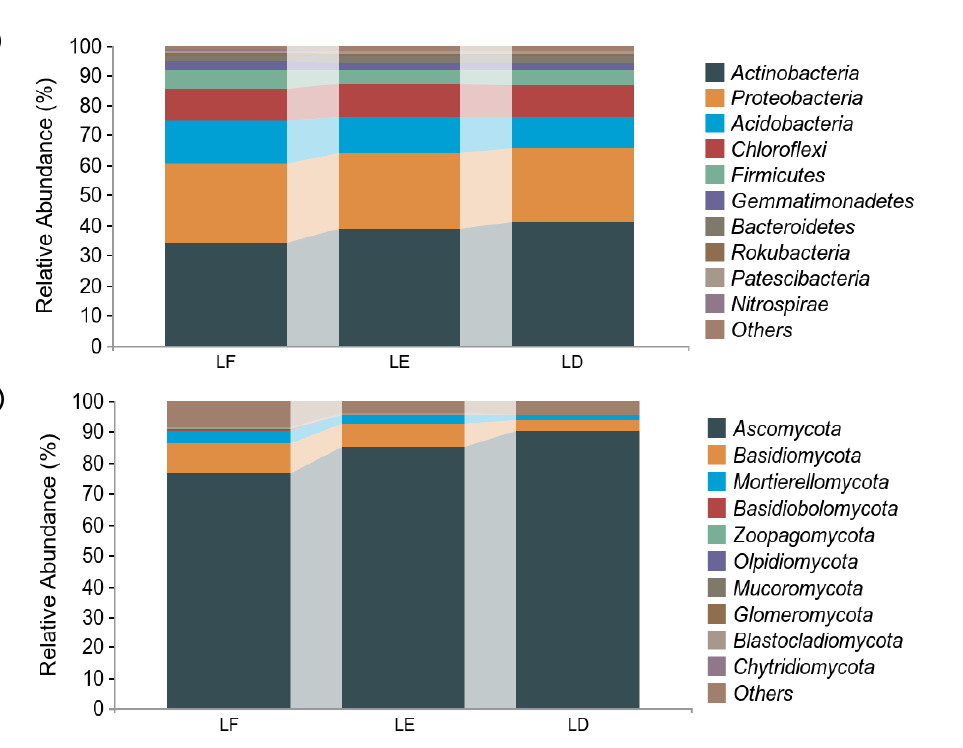
Figure 1. Relative abundance of bacteria and fungi at phylum in rhizosphere soil. ( a ): Relative abundance of bacterial phylum-level species composition. ( b ): Relative abundance of fungal phylum-level species composition. LF: Morus alba ; LD: Arachis hypogaea ; LE: Morus alba-Arachis hypogaea .